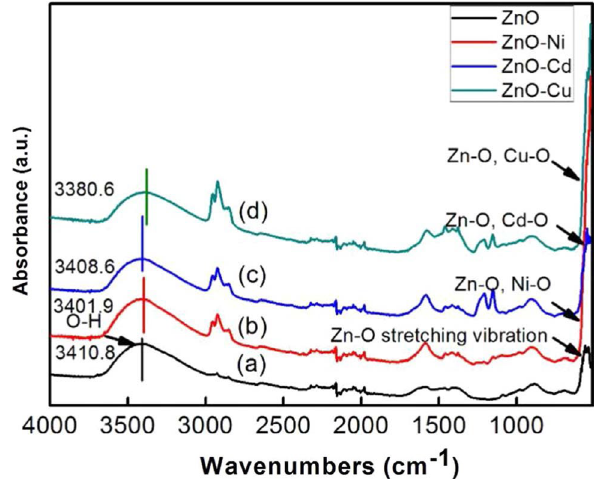
Fig. 2 The attenuated total reflection-Fourier transform infrared spec- tra of a ZnONPs before adsorption and after adsorption of b Ni(II) c Cd(II) and d Cu(II) ions from solution. Reproduced from (Wang et al. 2018) with permission from Elsevier. The peaks of hydroxyl groups (3400 cm −1 ) migrated to lower wavenumbers after the adsorption of Ni, Cd, and Cu ions, showing that the adsorption might be attrib- uted to the interaction between the metal ions and hydroxyl groups. Meanwhile, when compared to pure ZnONPs, the absorption peaks of metal-O located around 546 cm −1 of the Zn–O stretching enhanced after adsorption, suggesting that metal-O bonding was created after engaging with hydroxyl groups, particularly significant for the Cu–O bond. The hydroxyl group shift of ZnO (30.2 cm −1 ) following Cu ion adsorption is larger than that of Ni (8.9 cm −1 ) and Cd (2.2 cm −1 ), indicating that ZnO and Cu have the strongest binding contact